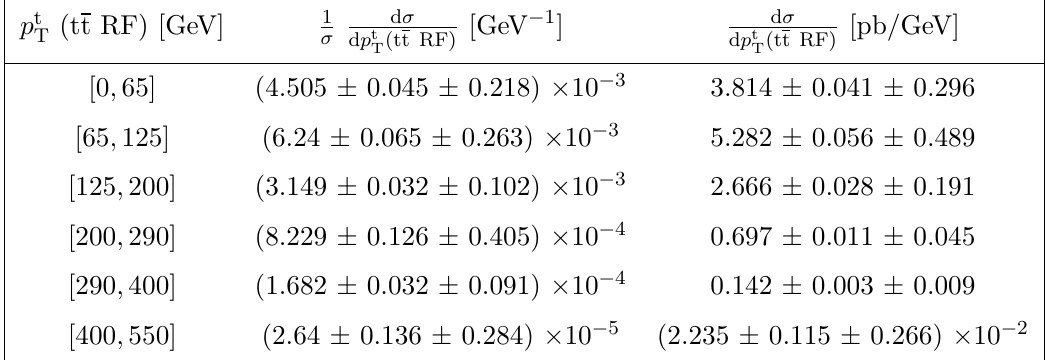
Table 5 . The measured di(cid:11)erential cross section and bin boundaries for each bin of the normalized and absolute measurements of the tt di(cid:11)erential cross section at parton level in the full phase space as a function of p t (tt RF) are tabulated. T